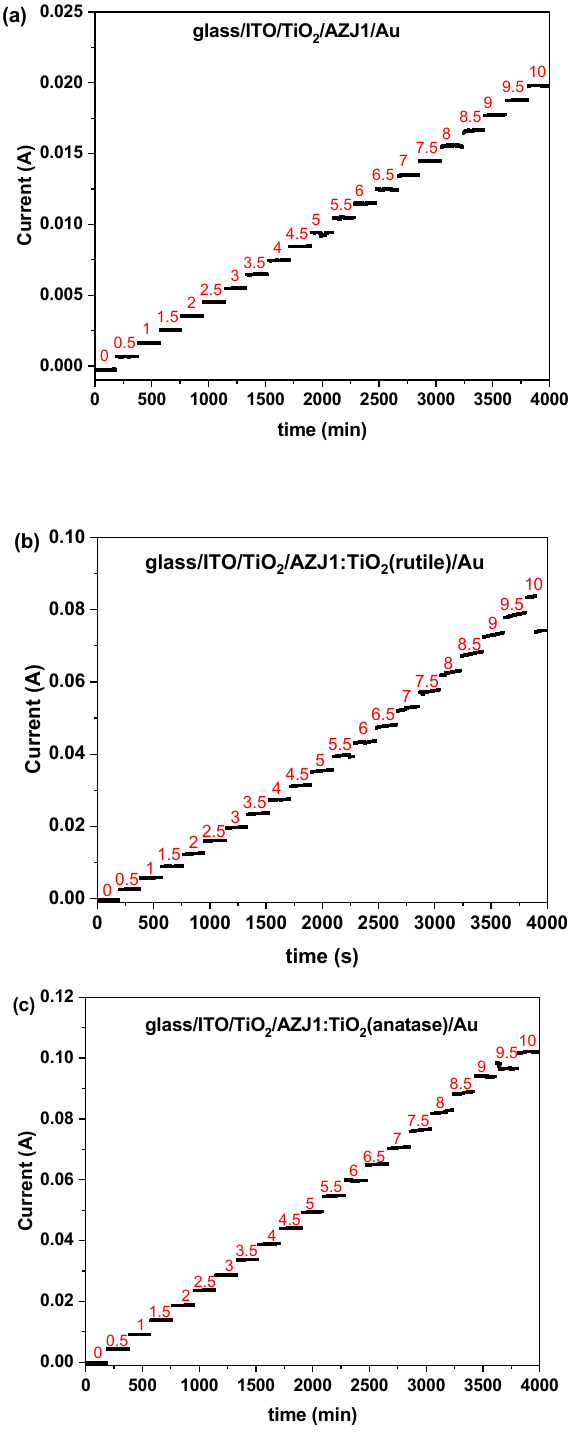
Figure 11. The correlation of current flow versus time at different applied potentials for constructed devices containing only AZJ1 ( a ), and mixture of AZJ1 with TiO 2 in form of rutile ( b ) and anatase ( c ), where numbers from 0 to 10 are the applied voltage in [V].